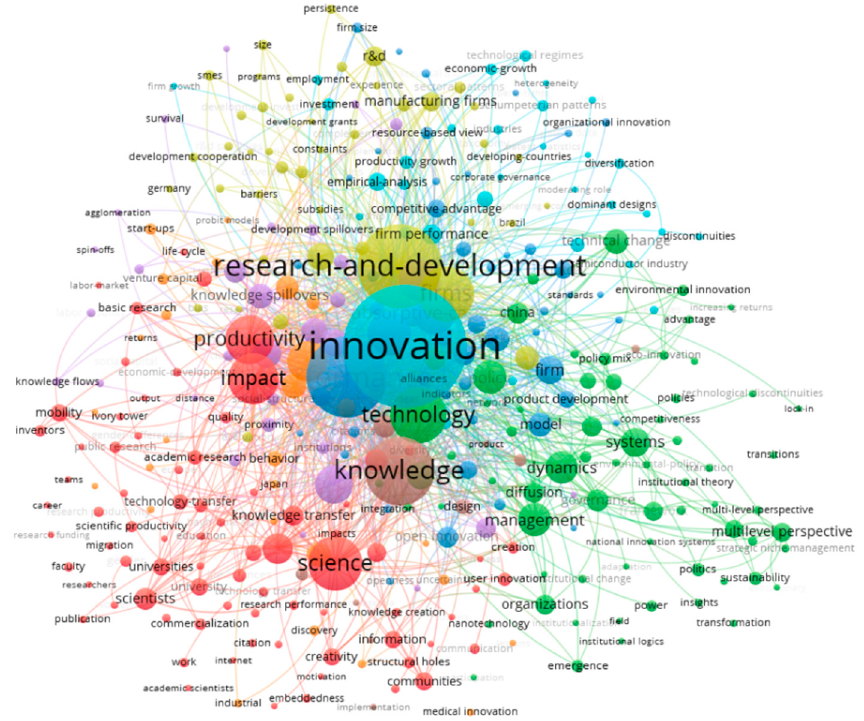
Figure 5. VOS Viewer: keywords from the Research Policy Journal. There were eight clusters detected in this journal; the total number of keywords was 345.